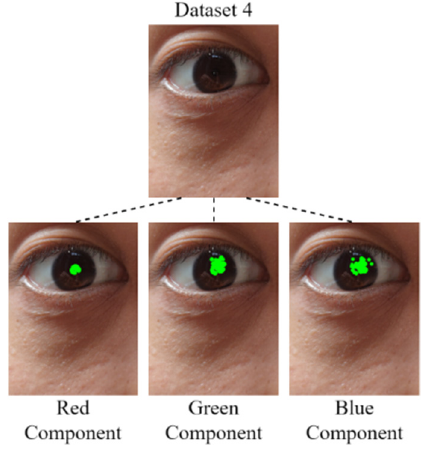
Figure 25. Image from Data Set 4.